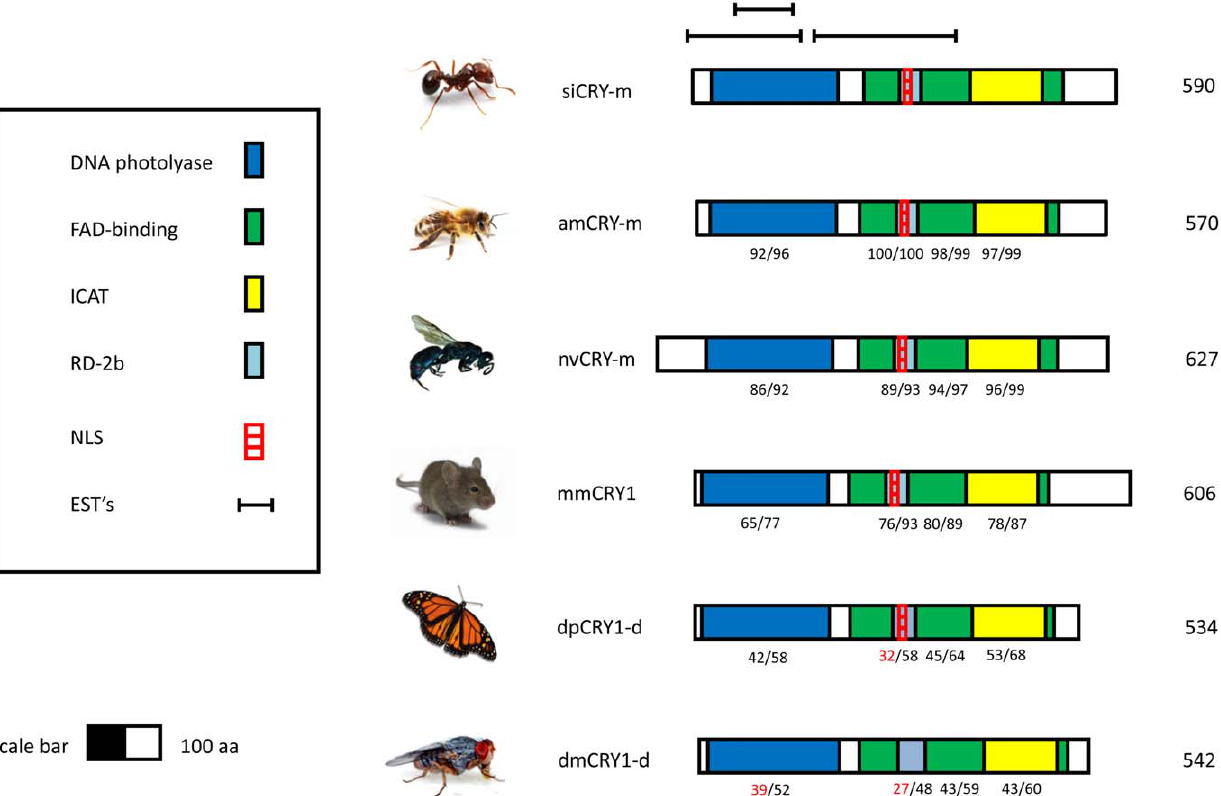
Figure 3. Schematic models for CRY proteins from various animals. The protein models depicted are from the fire ant Solenopsis invicta (siCRY), the Western honey bee Apis mellifera (amCRY-m), the fruit fly Drosophila melanogaster (dmCRY), the Monarch butterfly Danaus plexippus (dpCRY1) the jewel wasp Nasonia vitripennis (nvCRY) and the domestic mouse Mus musculus (mmCRY1). Highlighted areas on the diagrams represent putative functional domains and motifs. The numbers below the domains indicate percents of identity/similarity to corresponding sequences on the N protein of the fire ant. The numbers at the end of each diagram indicate the predicted protein size (number of amino acid residues). The protein N FAD binding. Proteins containing this domain are photolyases (DNA repair enzymes) or function as blue light domains on the CRY sequence are:. DNA photolyase. This domain is an evolutionary conserved protein domain from photoreceptors (Pfam domain accession number: PF03441). N bacteria to mammals. It binds to UV-damaged DNA containing pyrimidine dimers and, upon absorbing a near-UV photon 300 to 500 nm, breaks the ICAT - Inhibition CLOCK-ARNTL cyclobutane ring joining the two pyrimidines of the dimer (Pfam domain accession number: PF00875). N Transcription. A domain required for the inhibition of CLOCK-ARNTL-mediated transcription (Swiss-Prot record of mmCRY1 accession number: N N RD-2b – A domain defined by [58] based on studies with the clock proteins of the zebrafish. The domain is necessary for nuclear P97784). NLS - Nuclear localization signal in the RD-2b region, following [58]. EST - localization and the repression of CLOCK: BMAL-mediated transcription. Expressed sequence tags.